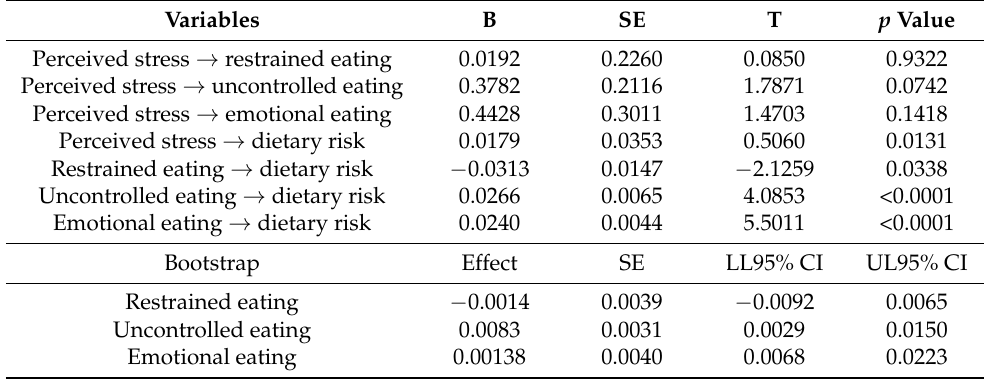
Table 5. Model 1 mediation analysis of eating behaviors on the relationship between perceived stress and dietary risk for